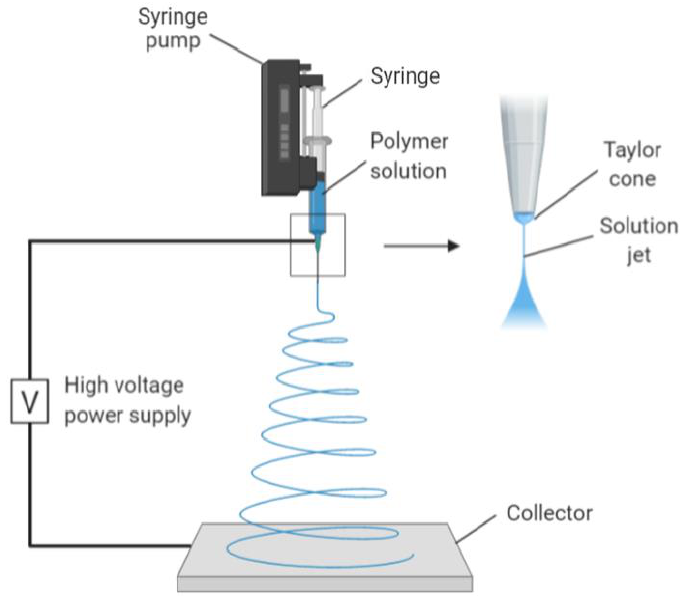
Figure 2. Image mechanism of electrospinning. Collagen polymer solution is fed through the syringe, forming a Taylor cone due to high voltage and low current. The electrostatic forces together with Columbic forces stretch and dehydrate the polymer ejected, forming dry and thin fibres on the collector. Created with Biorender.com (Accessed date: 10 February 2021).